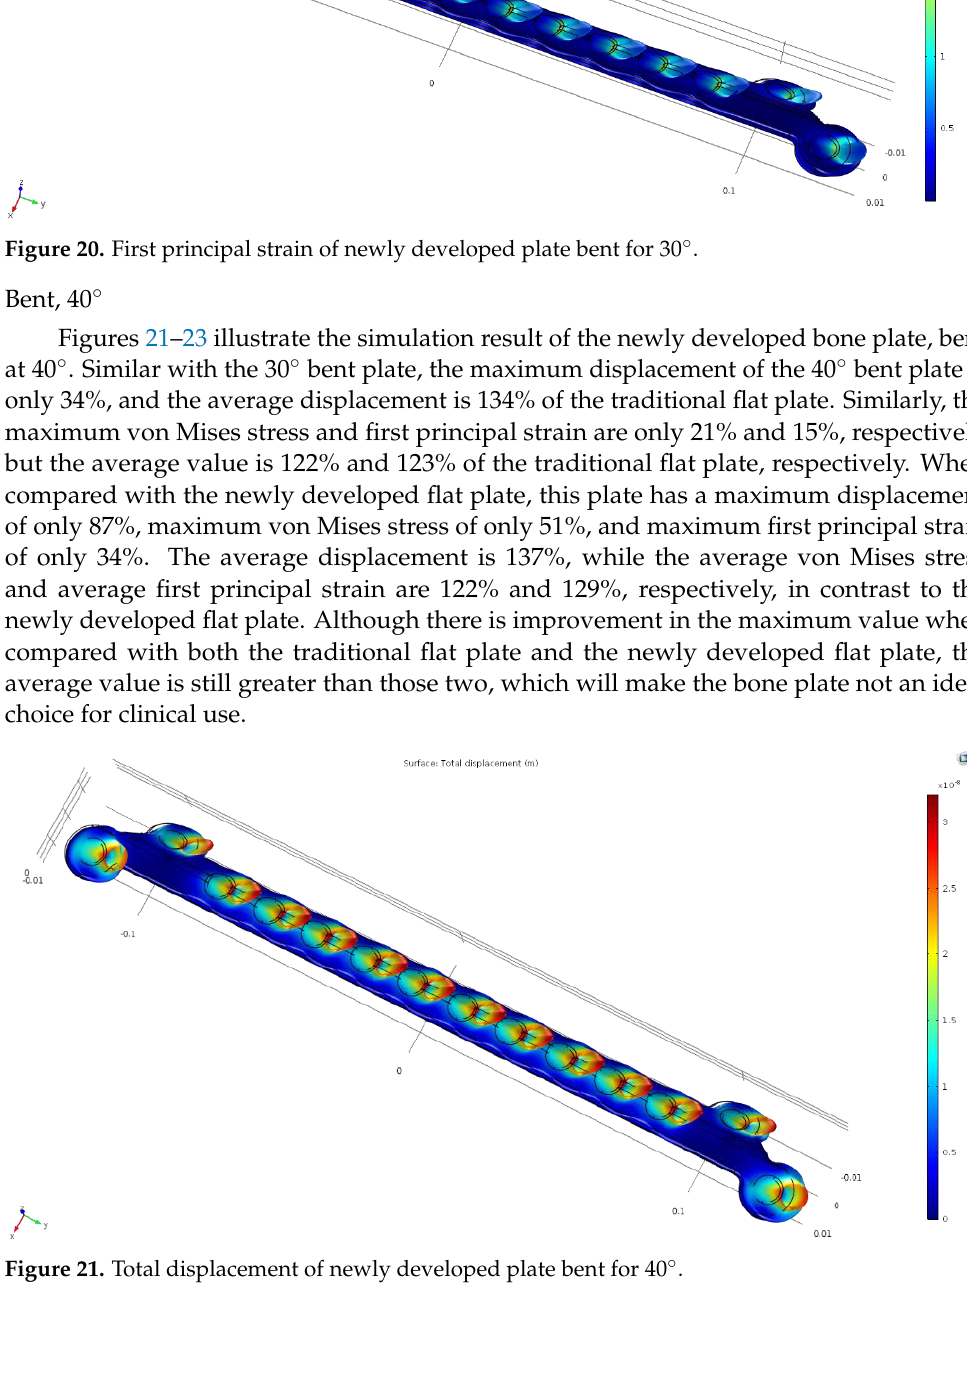
Figure 19. Von Mises stress of newly developed plate bent for 30°.